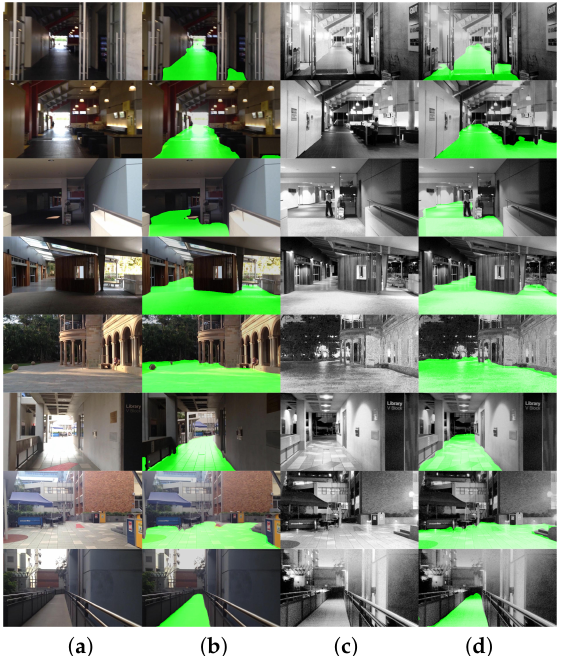
Figure 9. Qualitative examples of the traversable area segmentation on day/night images from the Gardens Point dataset [98] produced by our approach across indoor/outdoor environments. From left to right: ( a ) RGB images during the daytime; ( b ) traversable area parsing during the daytime; ( c ) RGB images at night; ( d ) traversable area parsing at